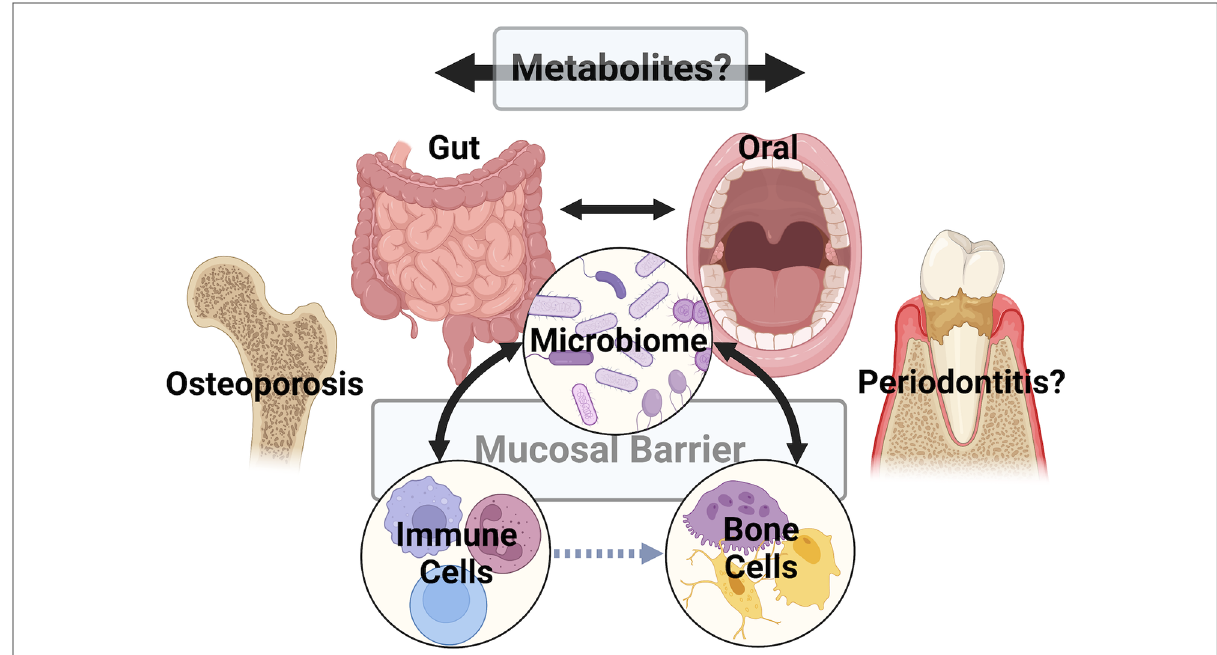
FIGURE 1 A multitude of studies have explored the connections between the gut and/or oral microbiomes, the host immune system, and bone cells (i.e., osteoblasts, osteocytes, and osteoclasts). Recent work suggests that metabolites are key signaling factors in these pathways (represented by black bidirectional arrows), acting directly or indirectly (i.e. via the immune system – gray dashed arrow) to in fl uence pathologic bone disorders like osteoporosis. A signi fi cant challenge is translating knowledge gained from studies of the gut and osteoporosis to the oral cavity to understand if metabolites play similar or distinct roles in the metabolism of alveolar bone. Underlying this challenge are differences in mucosal barrier structures, microbiome populations, and immune cells between the gut and oral mucosa. Figure created with